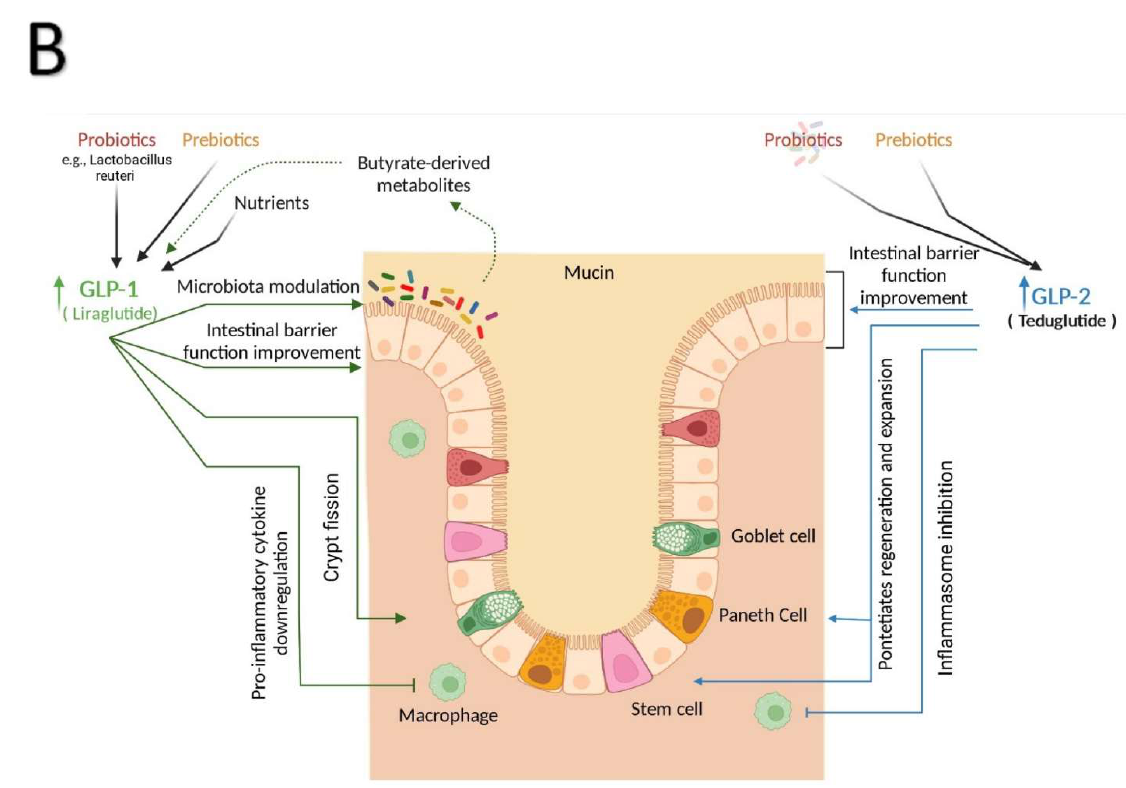
Figure 1. GLP-1 and GLP-2 signaling and the interaction with the gut inflammatory network and gut microbiota. ( A ) GLP-1 and 2 are produced by L-cells via enzyme-mediated cleavage of proglucagon. These gut peptides exert diverse effects through binding to their specific receptors, GLP-1R and GLP-2R, respectively. ( B ) Intestine-specific functions of GLP-1 and -2 are essential to maintain intestine–microbiota–immune system interactions. Created with BioRender.com.